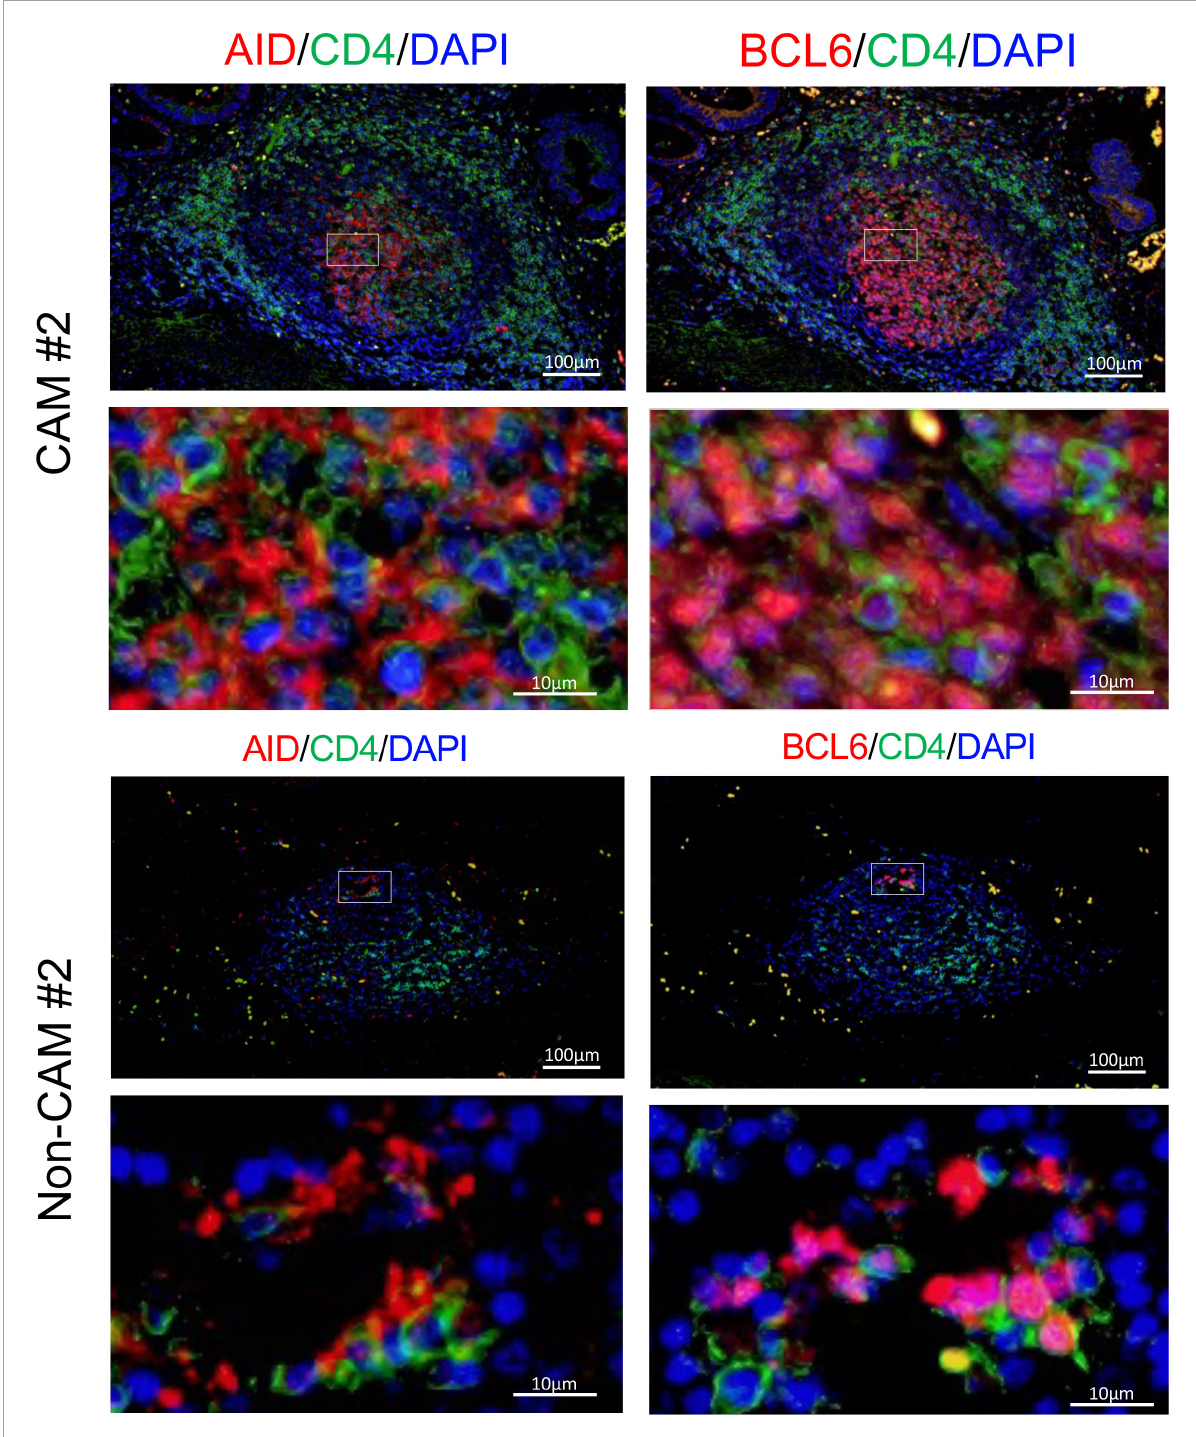
FIGURE8 CD4 − AID + class-switched B cells and CD4 + BCL6 + Tfh cells in TLS from a CAM patient and a non-CAM control. Immunofluorescent double-staining of CD4 and AID or BCL6 was conducted using sequential cancer sections. Representative images of the stomach cancer sections obtained from a CAM patient (CAM #2) and a non-CAM control (non-CAM #2) are shown. The staining of AID or BCL6 is shown in red, while CD4 staining is shown in green. Nuclei are counterstained with DAPI (blue). AID and BCL6 were stained in the cytoplasm and nucleus, respectively. The lower panel represents a high magnification image of an inset of the upper panel. Scale bar, 100 µ m (upper) and 10 µ m (lower). BCL6, B-cell lymphoma 6; TLSs, tertiary lymphoid structures; CAM, cancer-associated myositis; AID, activation induced deaminase; DAPI, 4’,6-diamidine-2’-phenylindole dihydrochloride; Tfh, T follicular